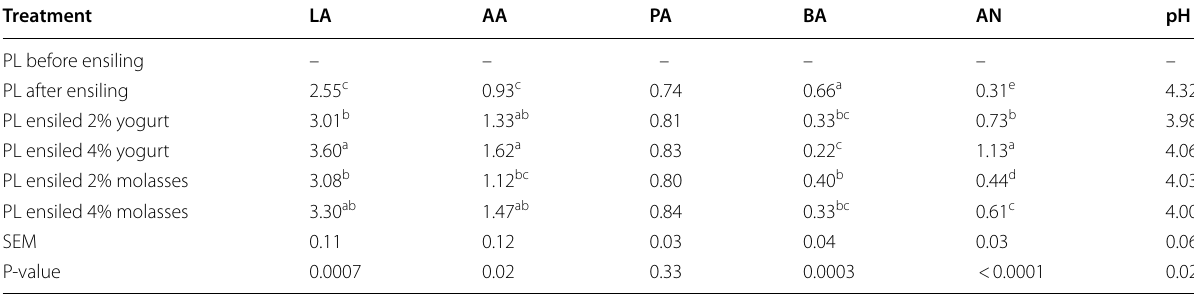
Means within columns followed by the same letter are not different PL pomegranate leaves, LA (% of DM) lactic acid, AA (% of DM) acetic acid, PA (% of DM) propionic acid, BA (% of DM) butyric acid, AN (% of total nitrogen) ammonia nitrogen SEM standard error of the mean